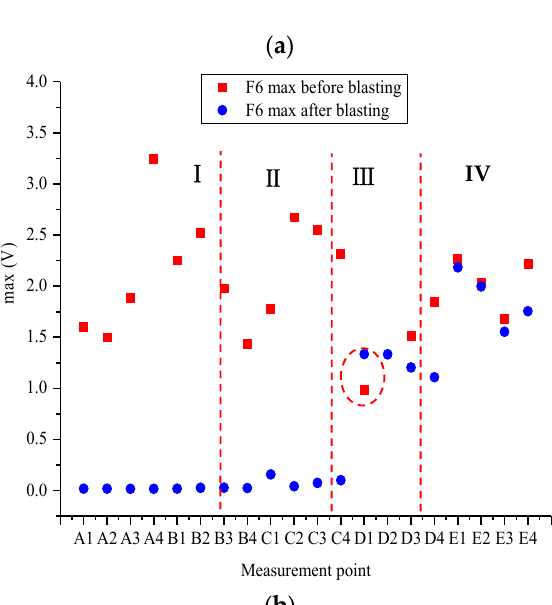
Figure 13. Peak value of piezoelectric signals at various measurement points for specimens ( a ) F5 and ( b ) F6.